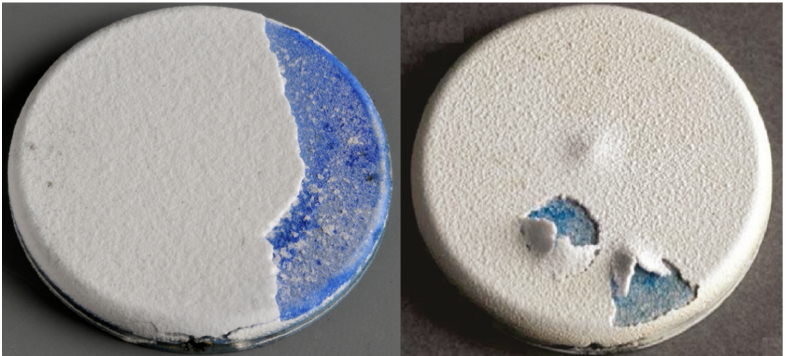
Figure 1. Top view of APS ( left ) and columnar SPS TBC ( right ) sample with yttria-stabilized zirconia top coat and conventional bond coat after test in the burner-rig facility, sample specification see Table A1 [2,24]